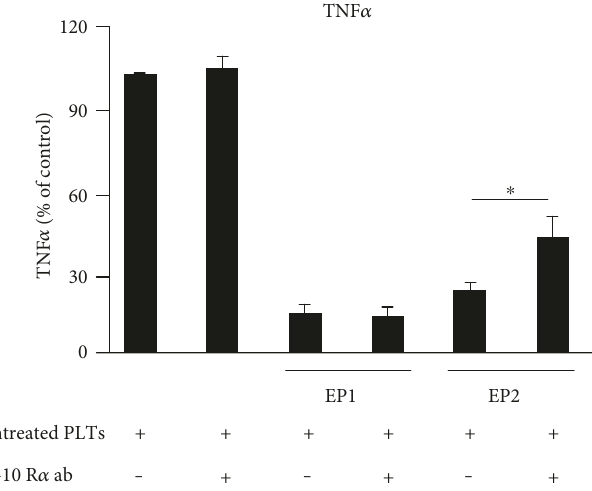
Figure 8: EP2 decreases TNF α through IL-10 and its receptor IL-10 R. Human monocytes were incubated with untreated platelets ± IL-10 R α antibody (22.5 μ g/ml) 30 minutes before the application of the respective EP agonist concentrations for 3 hours (40 nM ONO-Di-004, 75nM butaprost). TNF α was determined by ELISA. Data are presented as mean ± SEM from 4 preparations. One-way ANOVA/Bonferroni ∗ P < 0 05 .